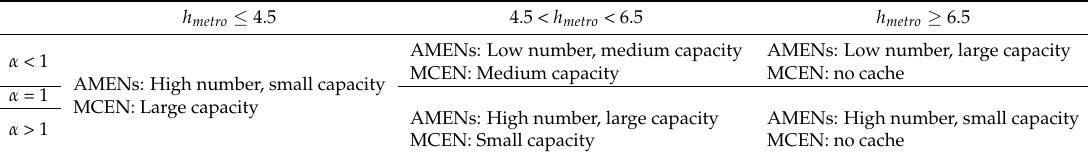
Table 5. Best cache deployment (number of caches and their storage capacities) among different network levels based on location of MCEN cache ( h metro ) and value of the popularity distribution skew parameter α .